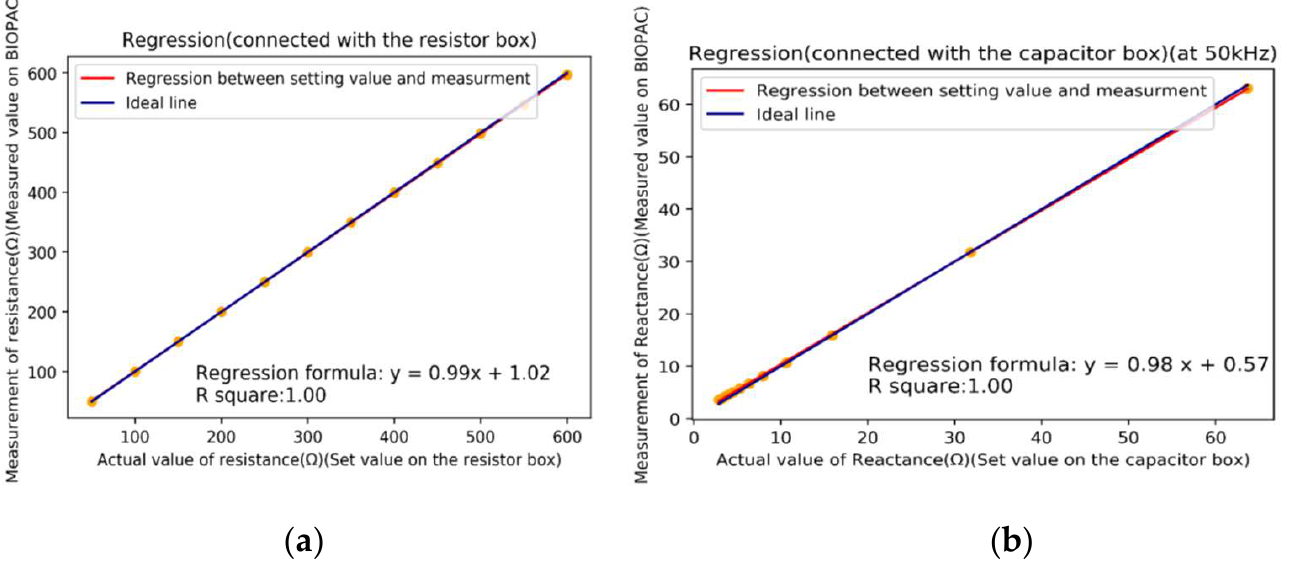
Figure 2. Placements of four electrodes and the distribution of electric field under the EIM measure- ment.